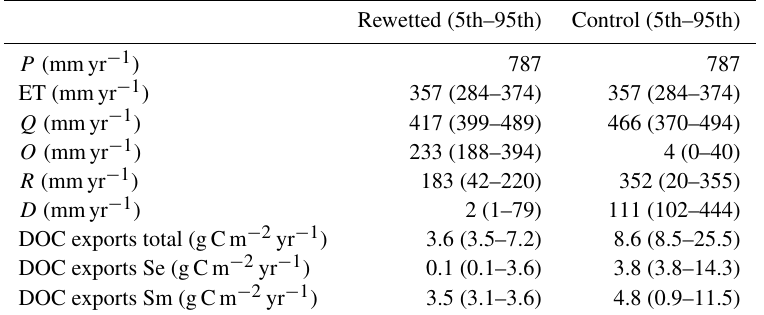
Table 2. Water and DOC balance computed for the simulated period (1 April 2014 to 1 April 2016 and 1 October 2016 to 10 December 2017) in rewetted and control areas. P is precipitation, ET is evapotranspiration, Q is total discharge, O is overland flow, R is macroporosity runoff and D is deep drainage. Best fit is indicated and 5th and 95th percentiles of the behavioural runs and are between brackets.